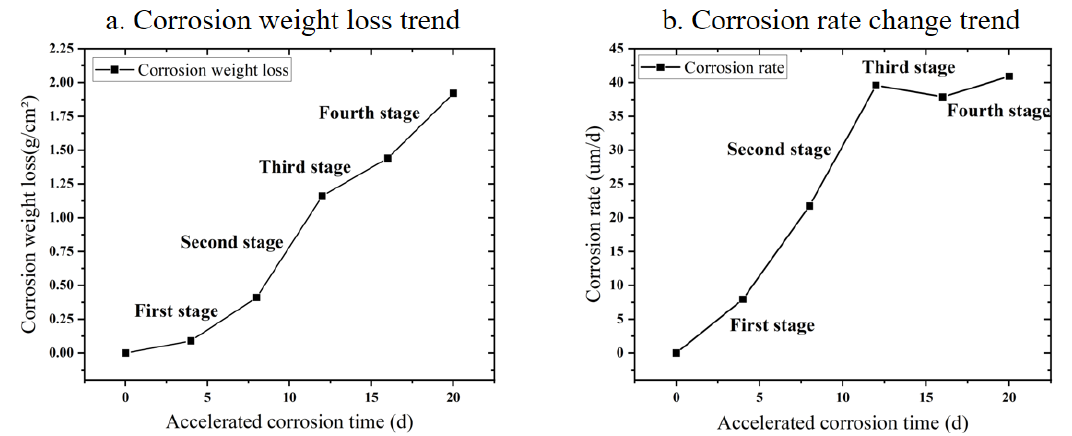
Figure 12. Corrosion kinetic analysis of Q235 low-carbon steel samples in an accelerated corrosive environment.